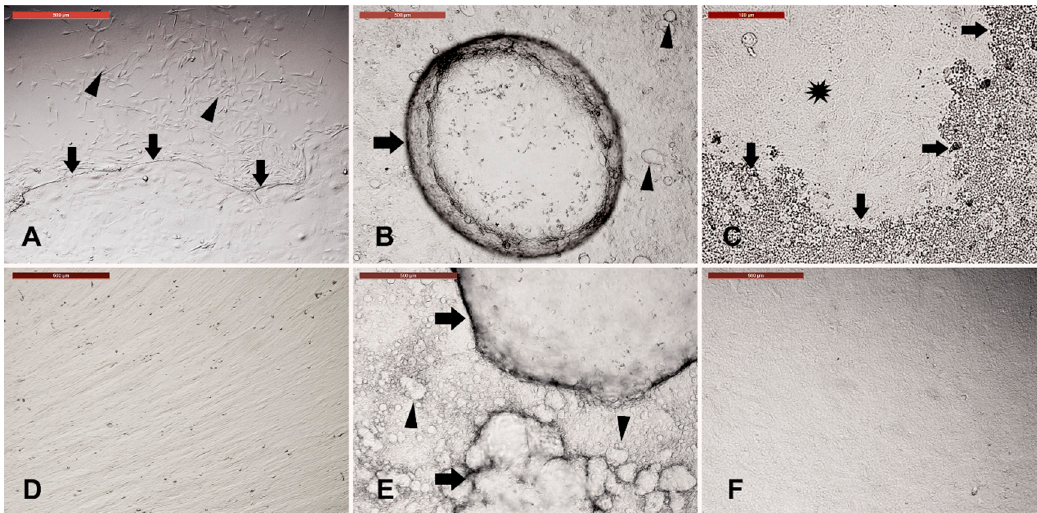
Figure 2. Long-term culture of camel skin explants. Explants were cultured for 21 ( A – C ), and further, for 28 ( D – F ) days while changing the culture medium after every two days. ( A ) Distinguishing fibroblasts (black arrow) from keratinocytes (white arrow). ( B ) Appearance of small (arrowheads) and big (arrow) fluid-filled cysts. ( C ) Appearance of cuboidal cells (asterisk) with melanin crystals (arrows) (Scale bar = 100 µm). ( D ) Fibroblasts reached confluency on day 28. ( E ) The fluid-filled cysts increased in both number (arrowheads) and size (arrows). ( F ) Formation of epithelial-like sheet with uniform cuboidal cells. Scale bars for all, except ( C ) = 500 µm.